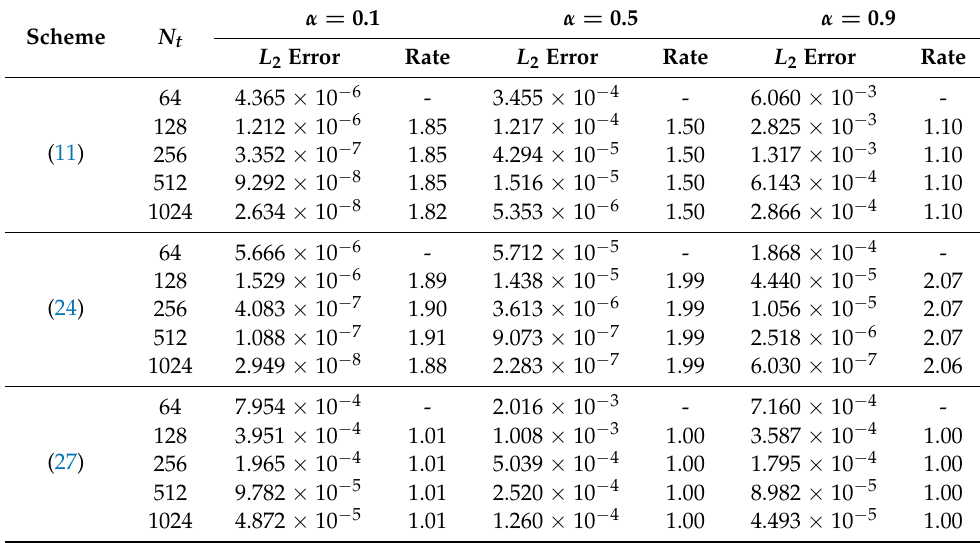
Table 3. The L 2 -norm errors in time for non-smooth case in Example 1 with h = 1/64, ϑ = α , κ = 1, r = 0.06, D = 0, and σ =